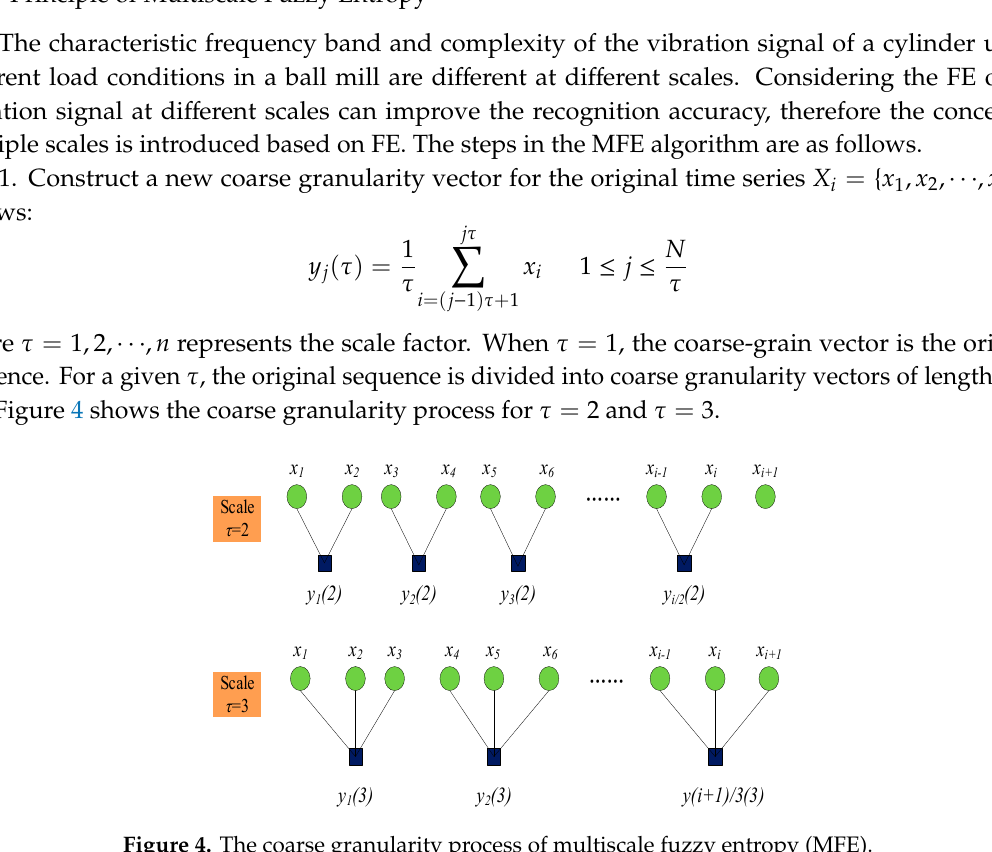
Figure 4. The coarse granularity process of multiscale fuzzy entropy (MFE).